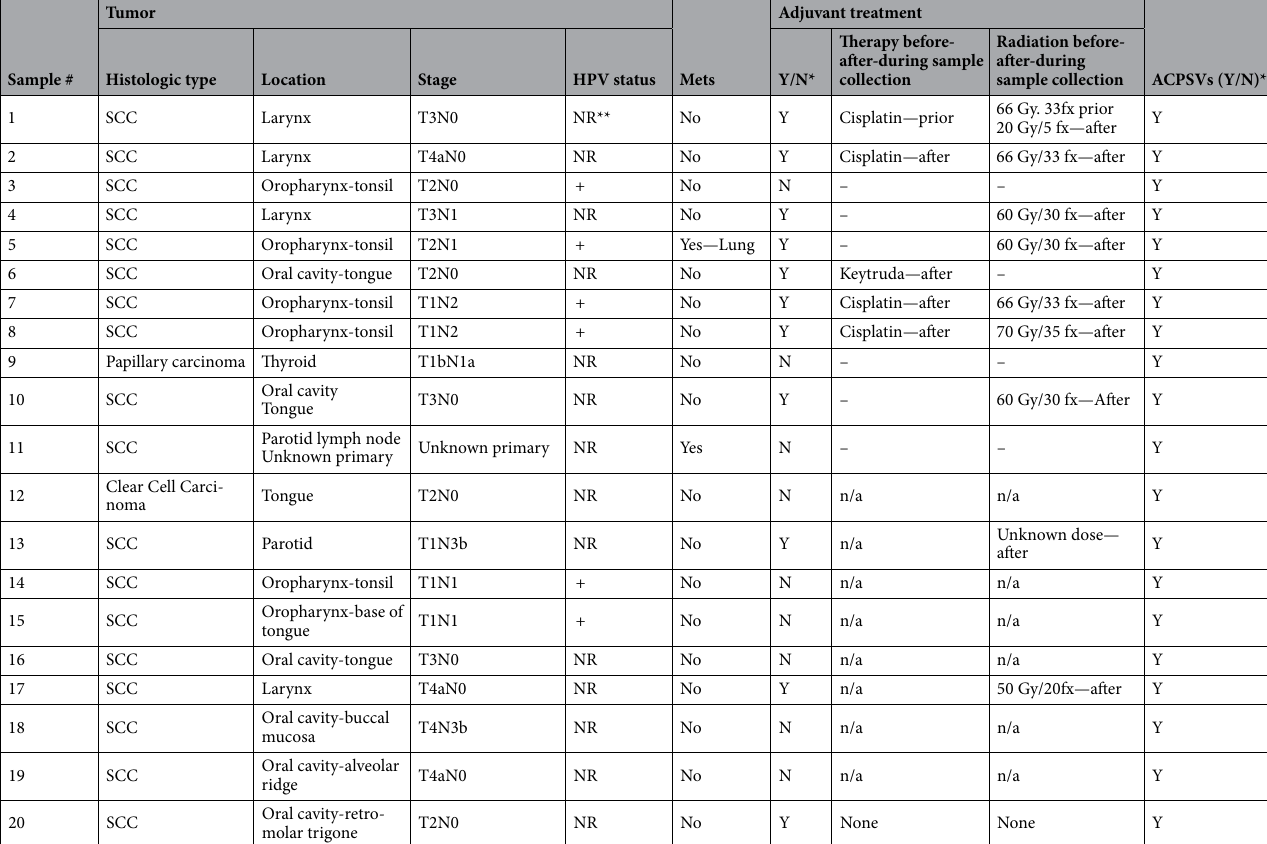
Table 1. CrkI-containing ACPSVs are prevalent in SCC tumors. *Y (Y = Yes; N = No), **(NR = Not Relevant) n/a = Not